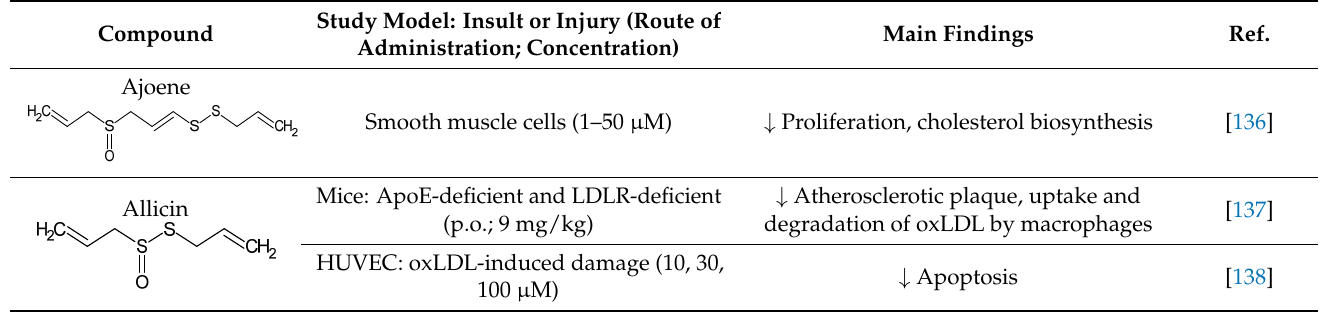
Table 3. Effects of sulphur-containing compounds on the cardiovascular system.